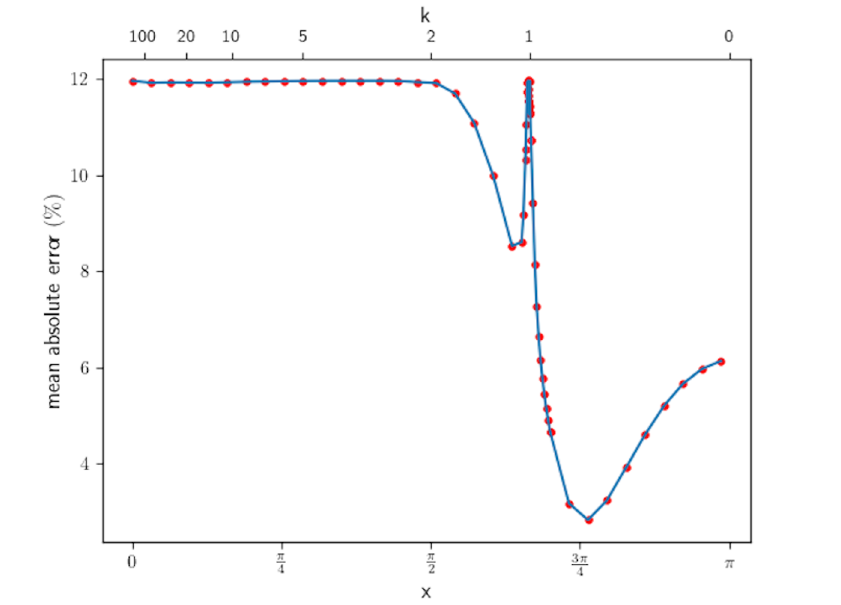
Figure 7 . Mean absolute errors as a function of x when optimizing the ansatz V ( K ) = a log( | J 2 ( K ; e ix ) | + b ) + c . We re-optimize the constants a , b , and c for each individual value of x . The minimum error of 2 . 83% occurs at x = 2 . 3 . This is evidence that we can approximate the hyperbolic volume from the Jones polynomial evaluated at a wider variety of fractional levels than just k = 1 or k = 2 2 3